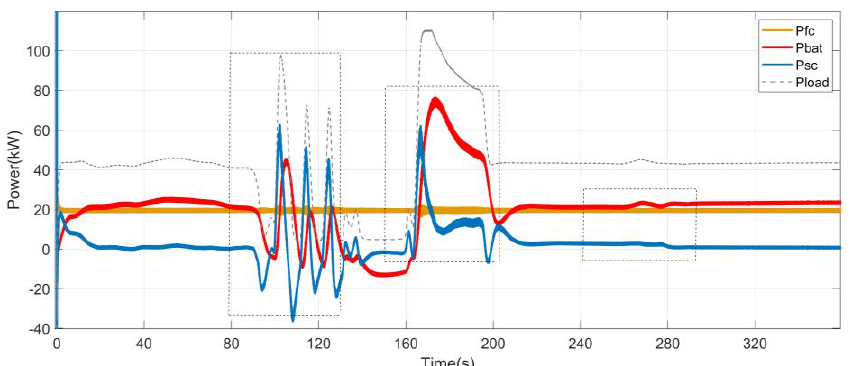
Figure 18. Power curve with variable filter time constants.